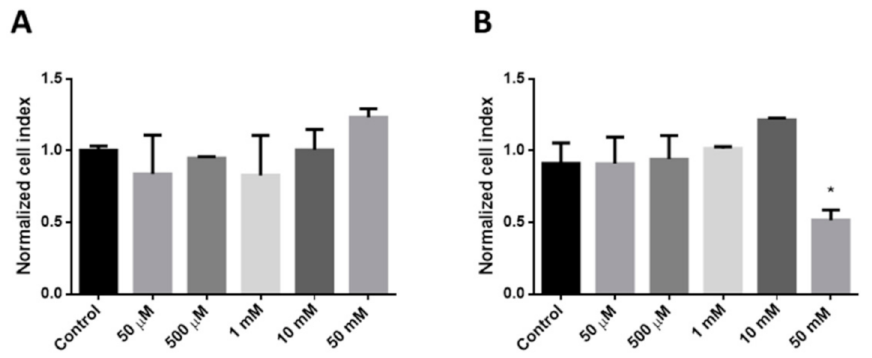
Figure 2. Cytotoxicity effects of HPBCD ( A ) and RAMEB ( B ) on Caco-2 cells after 30 min, measured by RTCA method. Mean ± SD are depicted ( n = 3). * p < 0.05 vs. control based on